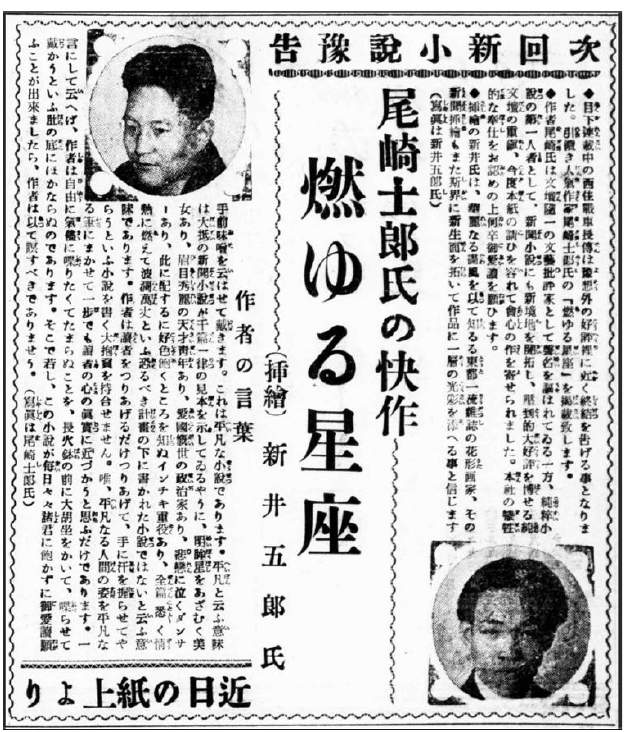
Figure 6. Preview of Constellations Ablaze . Burajiru jihō 31 October 1939. Image courtesy of the Hoji Shinbun Digital Collection.